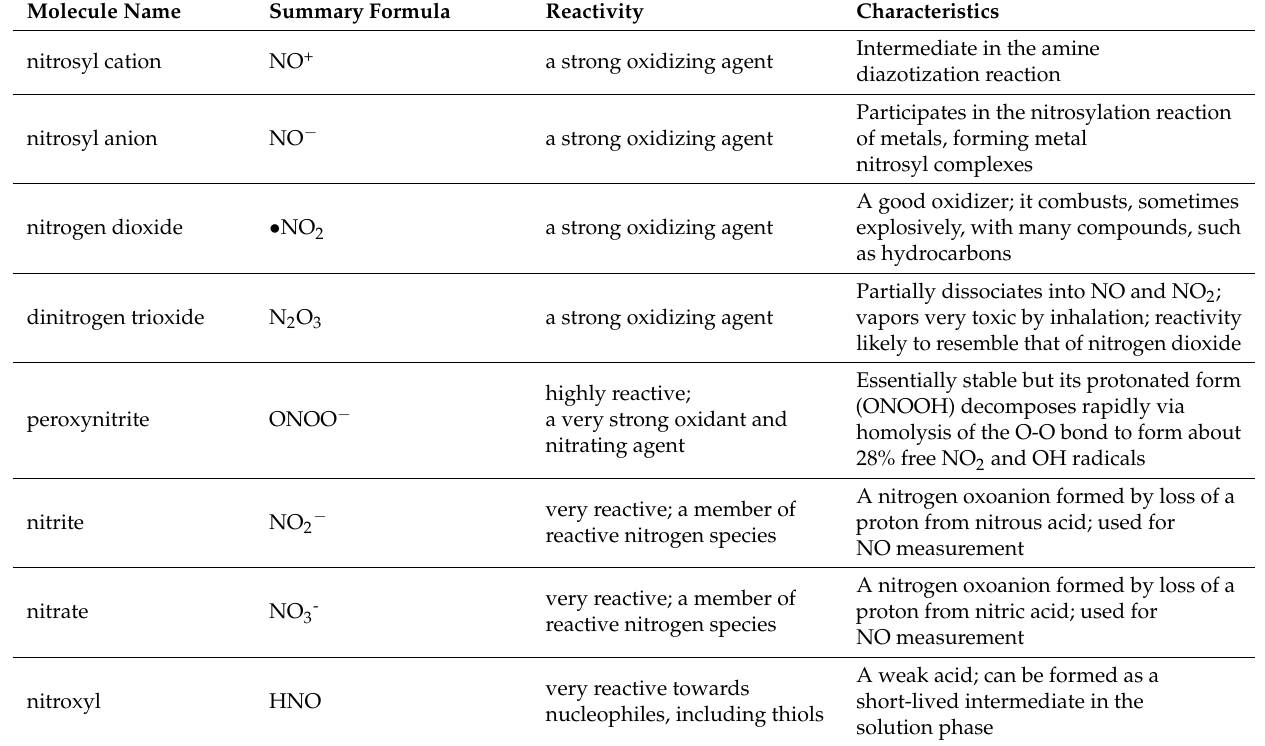
Table 1. The most well-known nitric oxide (NO) derivatives